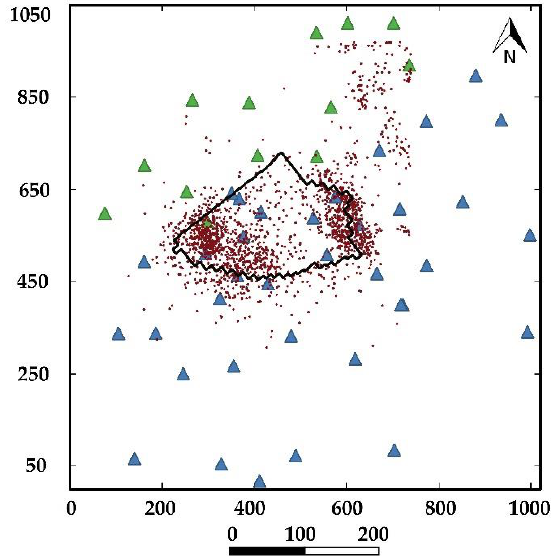
Figure 4. Distribution map of the station network showing the mining facilities (blue triangles) and the distribution of the off-facilities area station network (green triangles). The black dots indicate the distribution of earthquake events, and the cave is indicated by a black triangle.